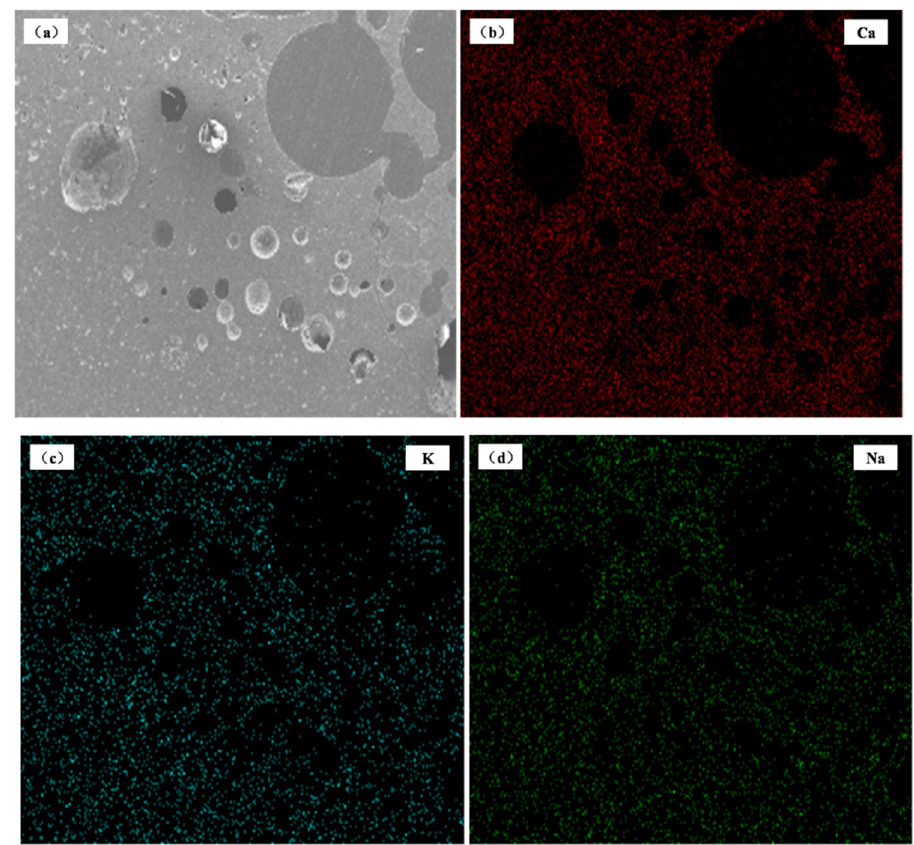
Figure 3: EDS results of the cross section of slag sample after reaction. ( a ) Morphology of slag cross section; ( b ) EDS result of Ca; ( c ) EDS result of K; ( d ) EDS result of Na..